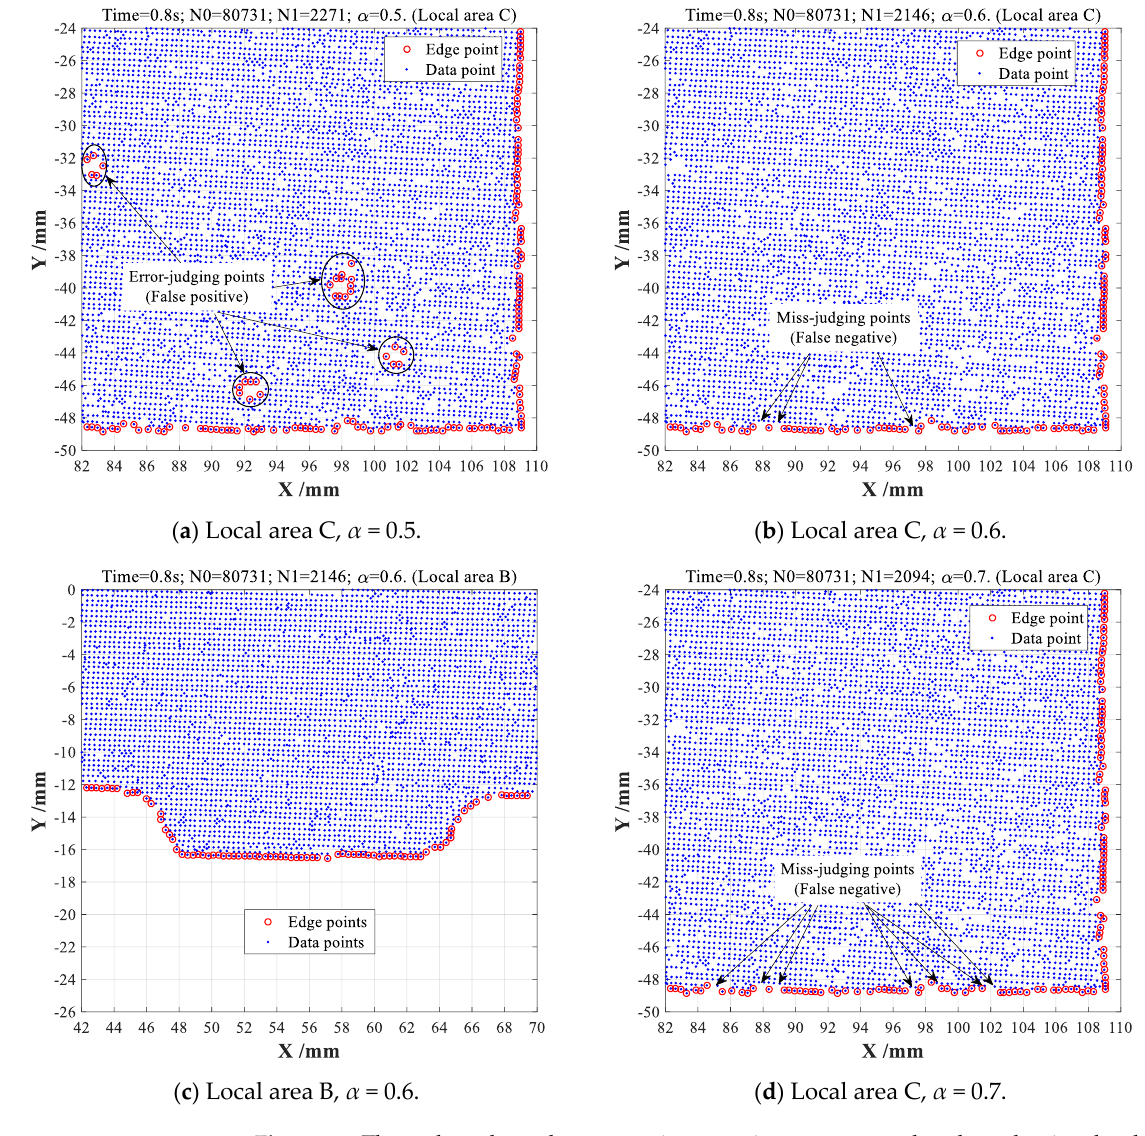
Figure 15. The α -shape boundary extraction experiments on complex-shaped point clouds.